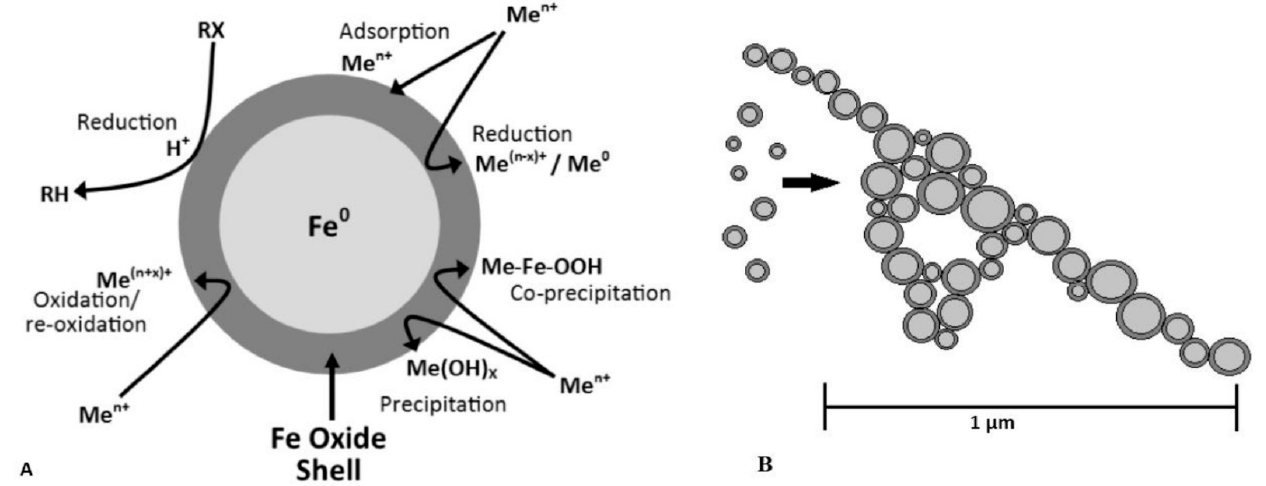
Figure 1. Metal ions removal using nZVI ( A ) is the mechanism and ( B ) is the particles aggregations. Reprinted with permission from [19] (2021,